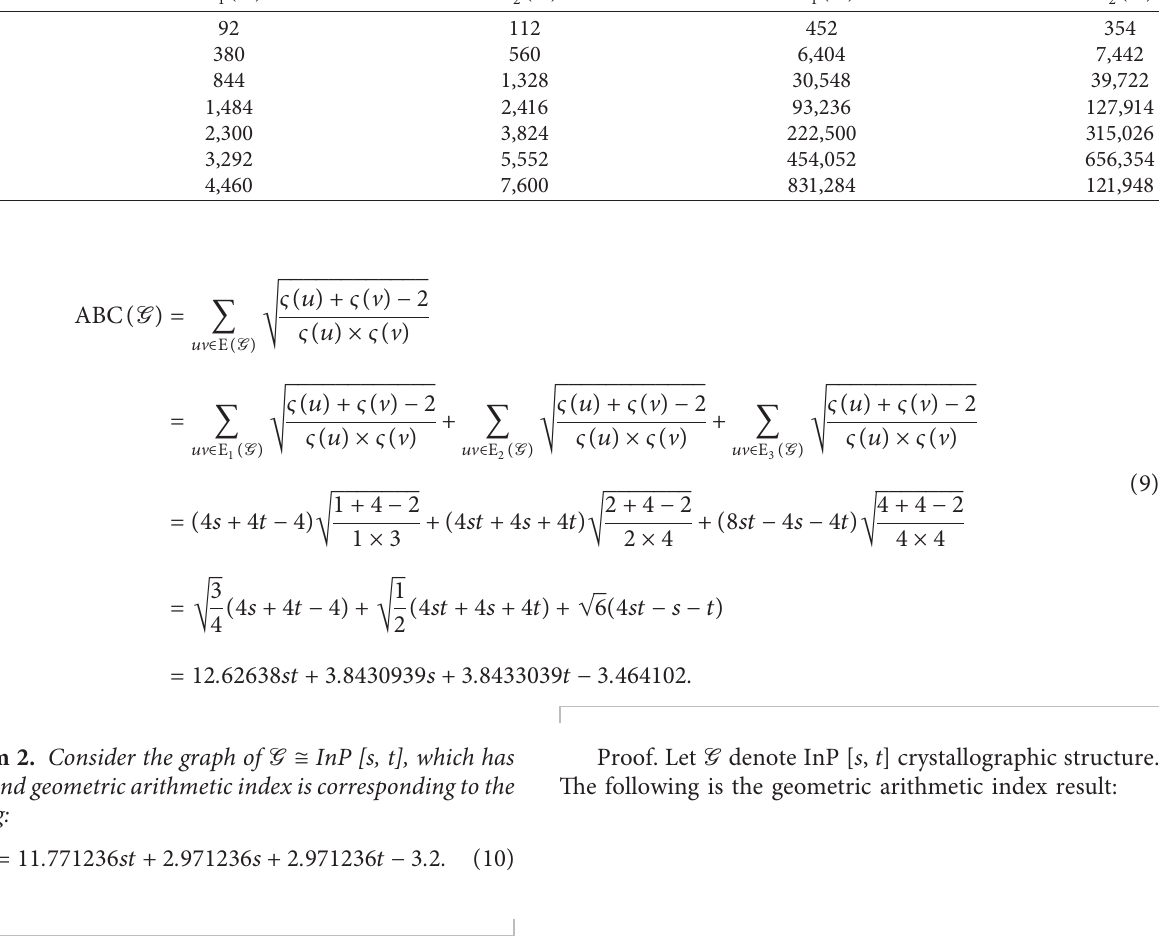
Table 3: Comparison of M